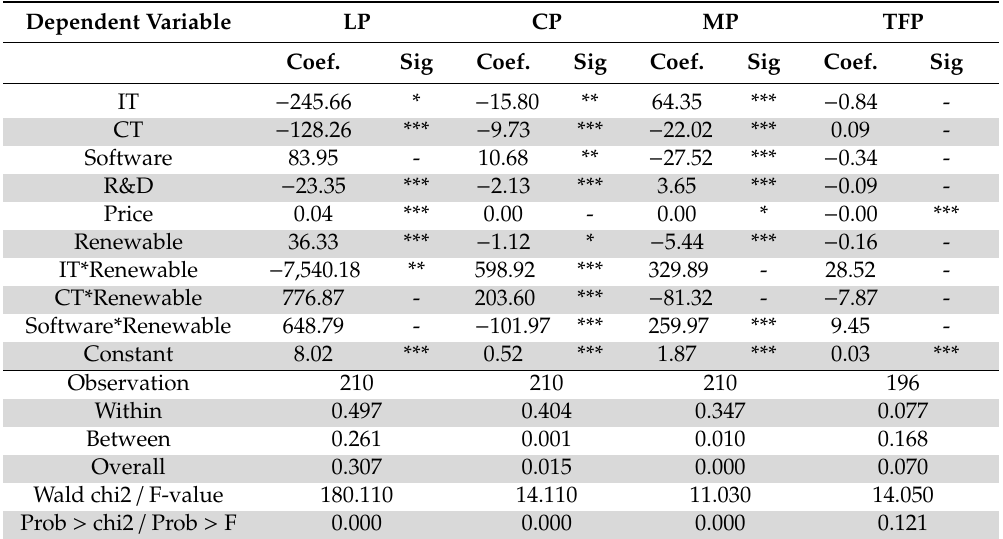
Table 5. The results of the determinant analysis using individual ICT capital with interaction